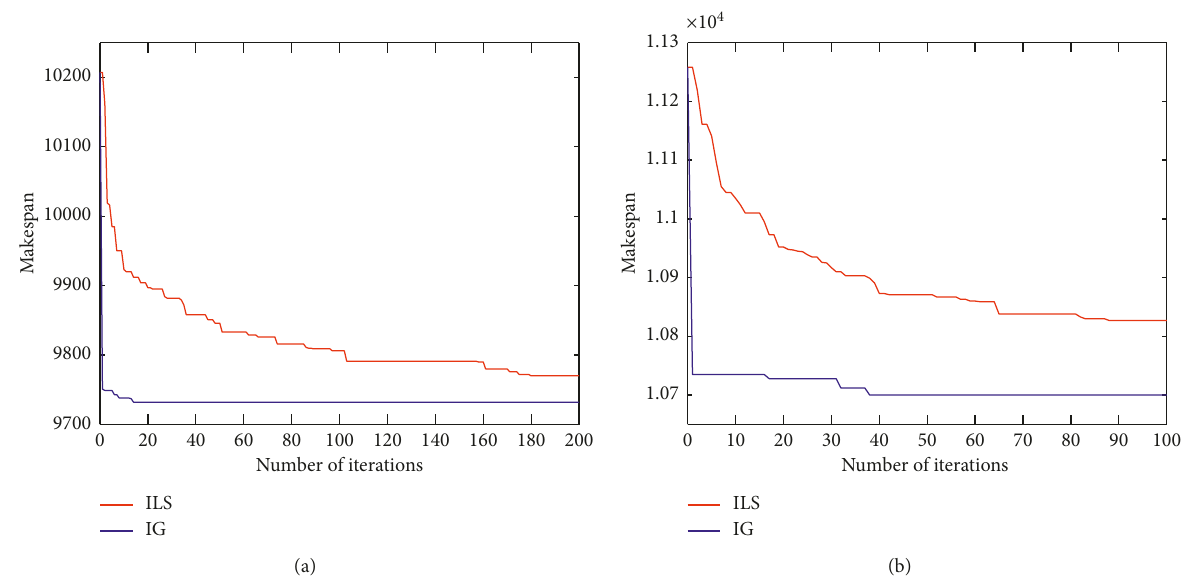
Figure 6: Makespan vs. number of iterations for n � 100 and m � 10 (a) and for n � 100 and m � 20